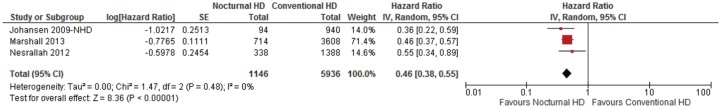
Comparative risk of mortality in nocturnal home HD versus conventional HD.